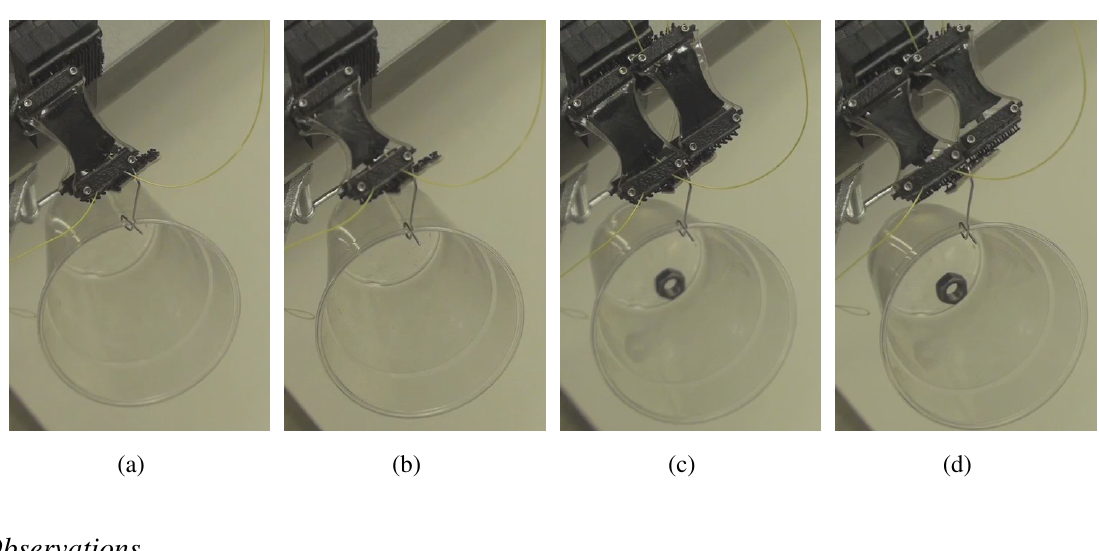
Figure 11. Alone, one module lifts a single nut from the 3,500 V state ( a ) to the 0 V state ( b ). Together, two modules lift two nuts from the 3,500 V state ( c ) to the 0 V state ( d